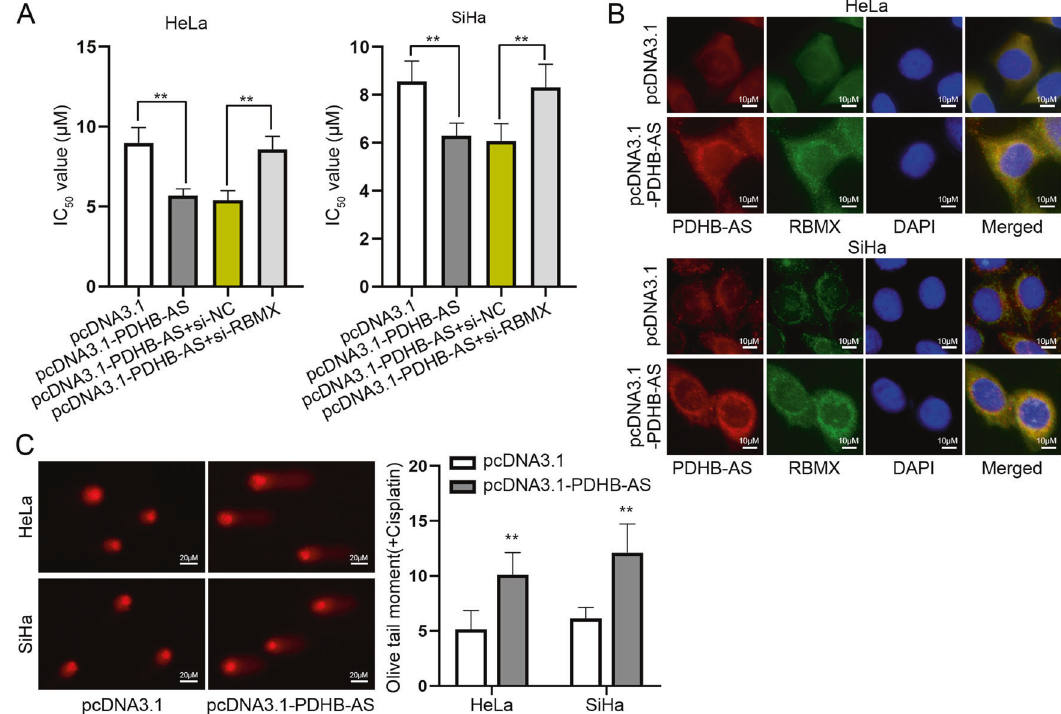
Fig. 6 PDHB-AS interacts with RBMX to affect cisplatin resistance in CC cells. A IC 50 values to cisplatin in HeLa and SiHa cells transfected with indicated plasmids including pcDNA3.1, pcDNA3.1-PDHB-AS, pcDNA3.1-PDHB-AS + si-NC, or pcDNA3.1-PDHB-AS + si-RBMX were detected. B IF and FISH experiments detected the distribution of PDHB-AS and RBMX in HeLa and SiHa cells with PDHB-AS overexpression. C DNA damage in HeLa and SiHa cells transfected with pcDNA3.1-PDHB-AS upon cisplatin treatment was detected by comet assays. ** P < 0.01.